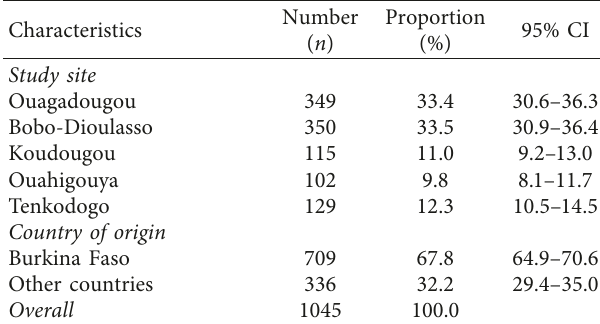
Table 1: Characteristics of female sex workers in Burkina